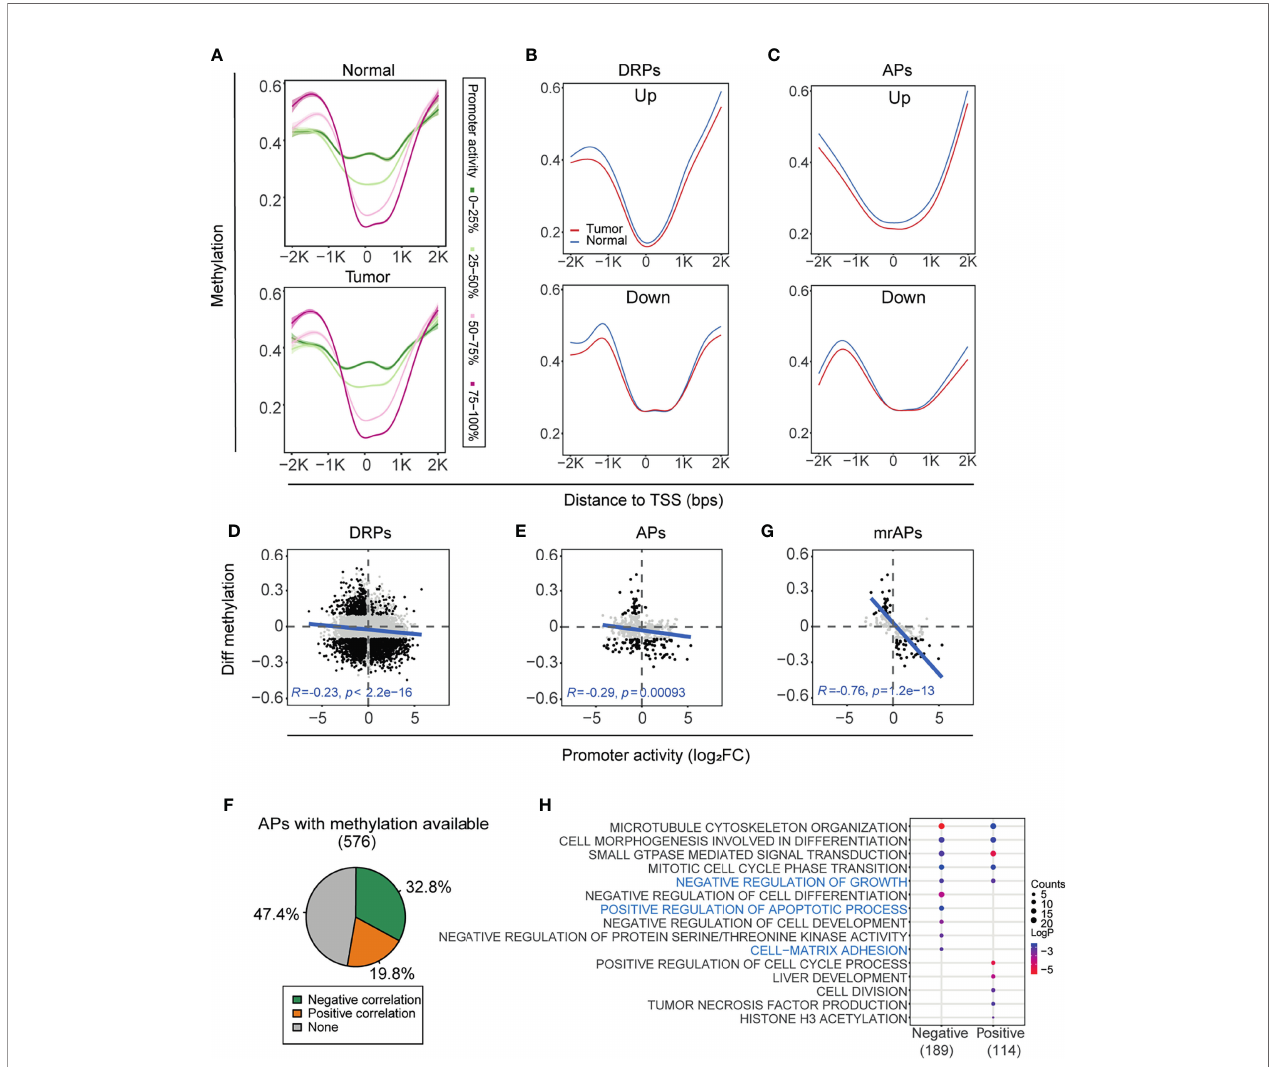
FIGURE 3 | The activity of AP was signi fi cantly correlated with DNA methylation status. (A) Methylation levels of CpGs within ±2 kbps relative to TSS were assessed in four groups classi fi ed by the quartiles of promoter activities. Methylation pro fi le was smoothed by gam (Generalized Additive Models). Green to red represents the promoter activity levels from 0 to 100%. (B, C) The methylation pro fi le showing mean methylation levels of TSS nearby region ( ± 2kb) of the DRPs (B) and APs (C) . Upregulated (top) and downregulated (bottom) promoters were shown separately. The blue line and red line represent normal and HCC samples, respectively. (D, E) Scatter plots showing the correlation between differential methylation (HCC – normal) and promoter activity by normalized change fold for DRPs (D) and APs (E). The representative CpG sites were fi ltered from the ±1kb upstream and downstream of TSS (see also Materials and Methods ). Black dots represent the differentially regulated promoters with signi fi cant methylation changes (|Diff. methylation| > 0.1); only these black dots were used for the Pearson correlation test. (F) The proportions of correlation categories between the promoter activities of APs and their methylation status are shown in the pie chart. Negative, positive, and no correlations are colored by green, orange, and gray, respectively. (G) Similar to (D, E) , but for methylation regulated APs (mrAPs). (H) Bubble plots showing the enriched biological processes by gene ontology (GO) analysis of APs with negative and positive correlations in (F)